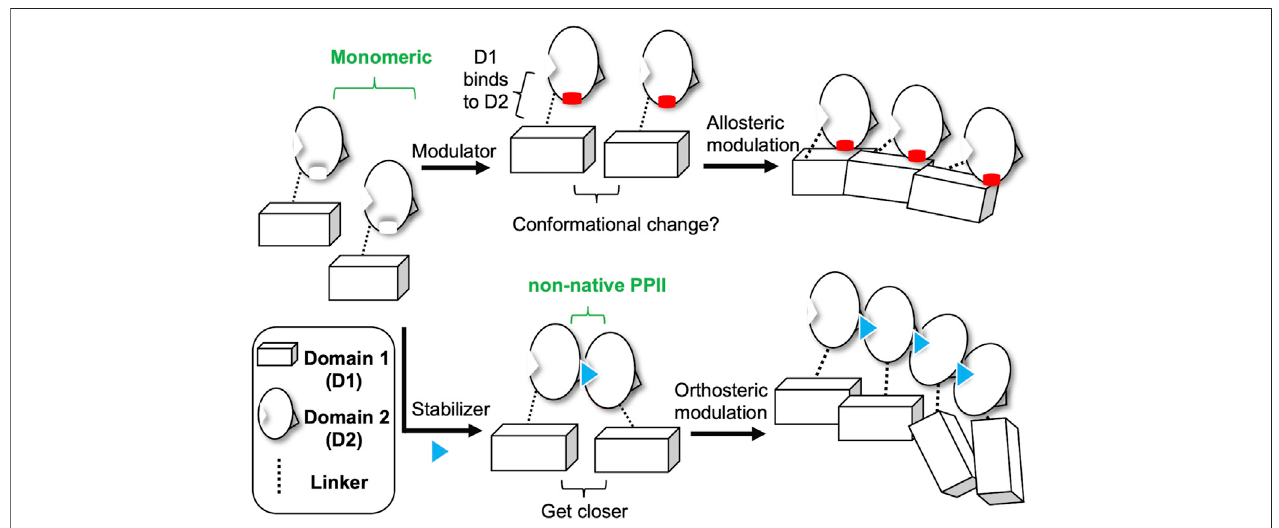
FIGURE5| Twodifferentmechanismsofsmall-moleculestargetingCoVN-NTDforinducingabnormaloligomerization.AllostericmodulatorbindstotheCoVN-NTDto createa hydrophobic fl atsurfacethateffecttheoligomerictendencyofN-CTD,which inducesthe abnormaloligomerization ofNprotein. Whereas,N-NTD stabilizeractson the non-native interface of CoV N-NTD dimer, which reduces the distance between targeted N proteins and eventually results in the aggregation of whole N protein.